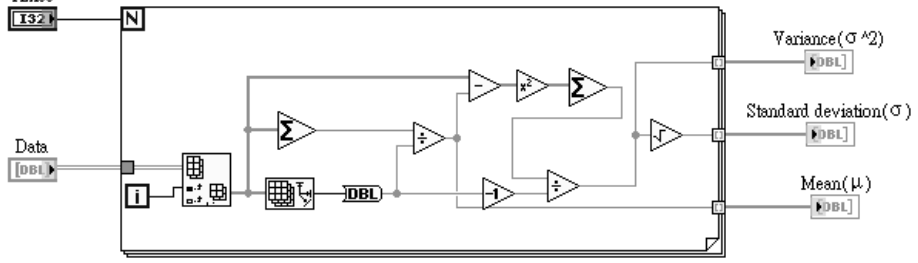
Figure 3. Block diagram of LabVIW for pre-calculation with measured data of the sensor array.